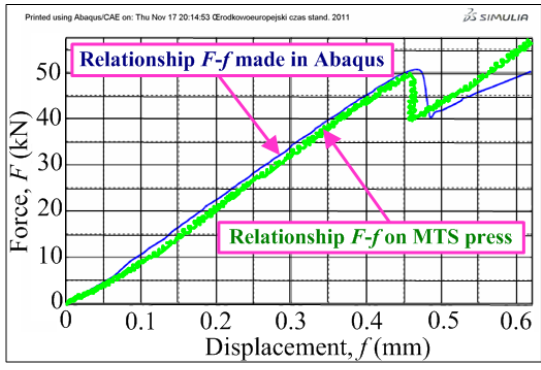
Figure 6. Comparison of force ( F )–displacement ( f ) diagrams for exemplary specimen.